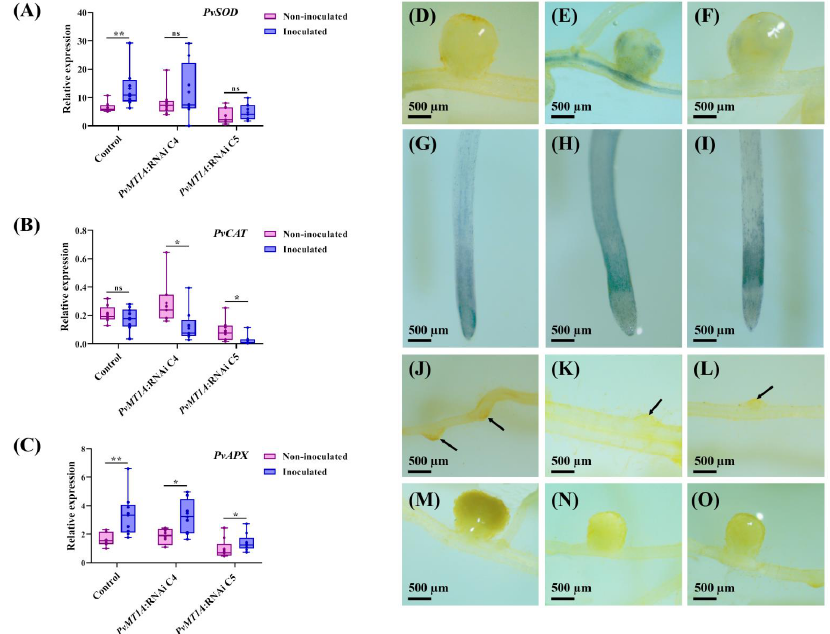
Figure 6. Expression levels of ROS gene markers and ROS production analysis in control and PvMT1A :RNAi transgenic roots. Relative expression profiles of PvSOD ( A ), PvCAT ( B ), and PvAPX ( C ) in control and PvMT1A :RNAi transgenic roots at 7 dpi with R. tropici evaluated by qPCR. The elongation factor EF1α and IDE genes were used as endogenous reference genes to normalize expression levels. The top and bottom edges of the boxes delineate the first to the third quartiles, the horizontal line within the box represents the median, and the whiskers represent the smallest and largest outlier in the data set ( n = 9). ( A ) Non-parametric Mann–Whitney test was performed to evaluate significant differences, * p ≤ 0.05, ** p ≤ 0.01, and ns = no significant difference. In panels ( D – O ), the visualization of O 2 − and H 2 O 2 in representative roots at 14 dpi with R. tropici CIAT899 by NBT and DAB staining are shown, respectively. The blue color indicates the presence of O 2 − in the tissue, and the brown color indicates the presence of H 2 O 2 in the tissues. Typical NBT-stained nodules of control transgenic roots ( D ), PvMT1A :RNAi C4 ( E ), and PvMT1A :RNAi C5 ( F ). Representative samples of control transgenic roots ( G ), PvMT1A :RNAiC4 ( H ), and PvMT1A :RNAiC5 ( I ) stained with NBT. DAB staining of representative early nodule primordia of the control ( J ), PvMT1A :RNAi C4 ( K ), and PvMT1A :RNAi C5 ( L ). Arrows in ( J – L ) indicate the presence of H 2 O 2 in the nodule primordia. Typical nodules of control ( M ), PvMT1A :RNAi C4 ( N ), and PvMT1A :RNAi C5 ( O ) transgenic roots stained with